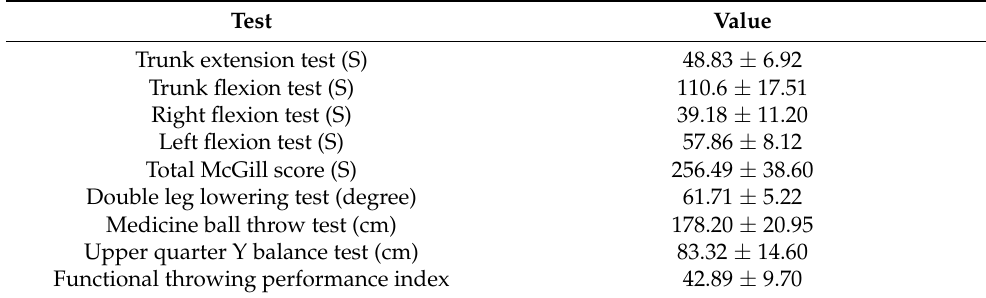
Table 2. Descriptive statistics core stability and upper-extremity performance test scores performed by the participants. Values are expressed as mean ± SD.